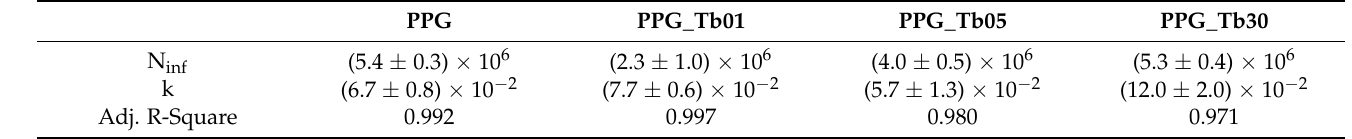
Table 2. Parameters of fitted linear functions for glass samples (dose 1–30 kGy).